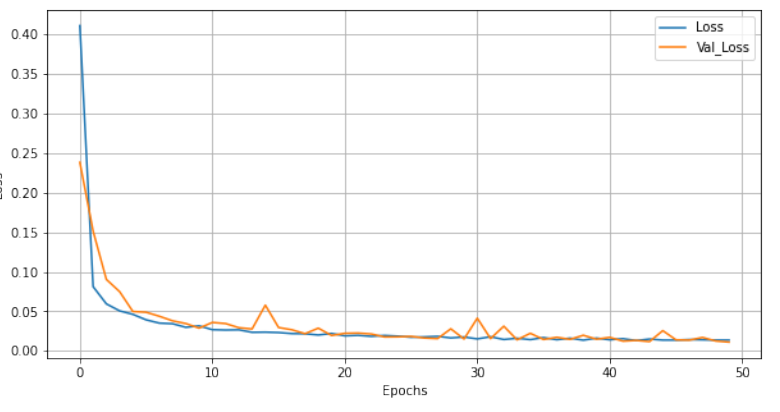
Figure 8. Loss curve.